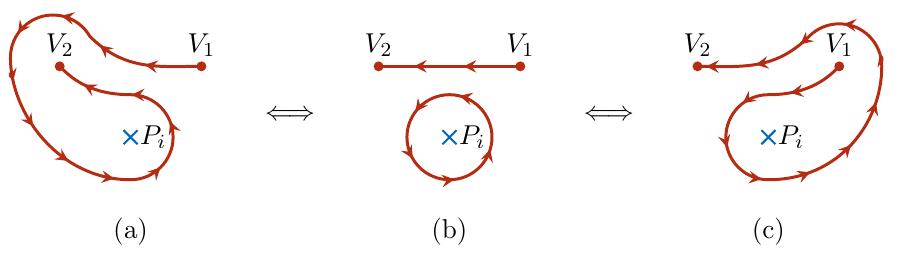
Figure 3 . The residue contour (b) can be obtained either (a) by deforming the 0 -face V 2 around the singularity point P or (c) by deforming the other 0 -face V i